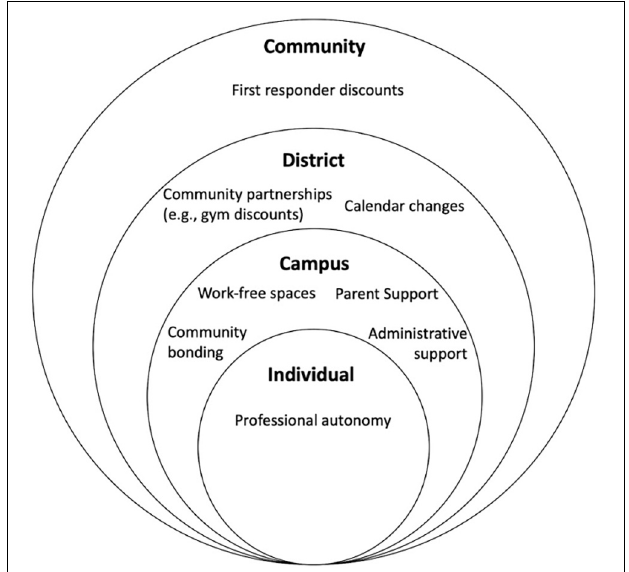
FIGURE 2 | Teachers’ desired resources for well-being are shown within a socioecological